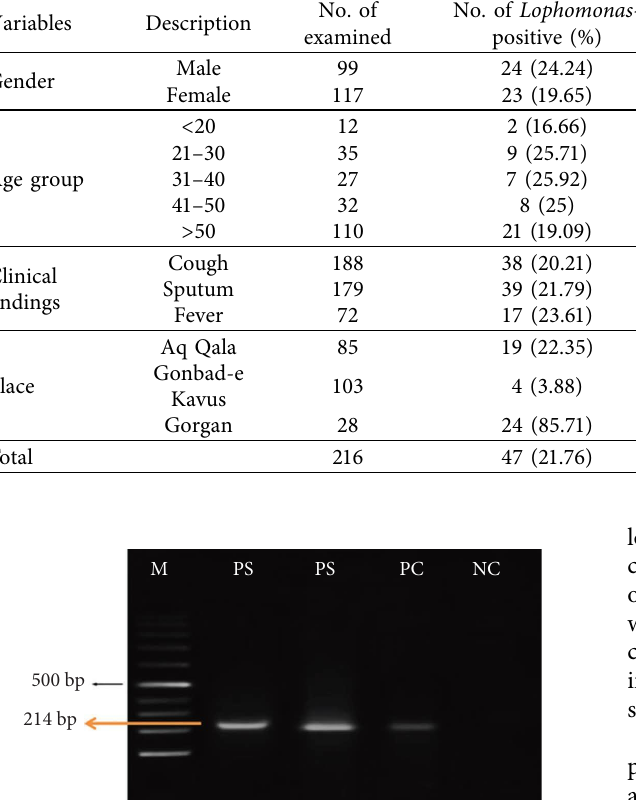
Table 1: Demographic and clinical characteristics of patients suspected of having pulmonary tuberculosis, Golestan Province, northeastern Iran. Variables